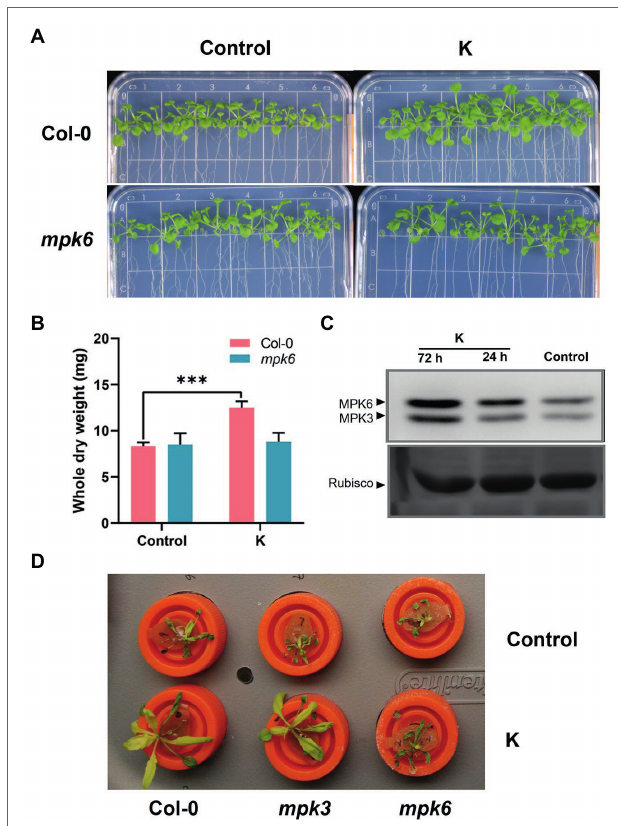
FIGURE 1 | Mucilaginibacter sp. K effects on the morphometric traits and MPKs activity of Arabidopsis. Effect of mpk6 mutant on the phenotype (A) and dry weight (B) of seed-inoculated Arabidopsis after 21 days of growth. A total of 10 plants were pooled for each replicate for dry weight. Error bars indicate SEM ( n > 10; *** p < 0.001). (C) Activation of MPKs in 14-day-old Arabidopsis Col-0 treated with strain K. Samples were collected at 24 and 72 h after inoculation. Rubisco in ponceau-S stained gel is shown as the loading control. The experiments were performed three times with similar trends. (D) Salt resistance by strain K is compromised in mpk6 mutant. All seedlings were seed-treated with strain K and hydroponically cultured for 21 days. The rosette was completed withered after 18 h exposure to 230 mM NaCl in mpk6 mutants in either absence or presence of strain